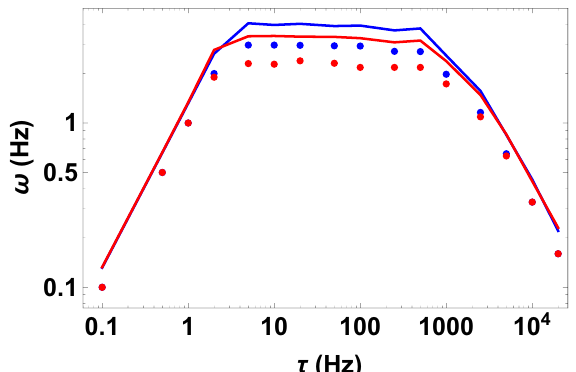
Figure 5. Angular frequency of the last circular trajectory of trapped enantiomers ( δ > 0 blue and δ < 0 red) versus τ (the continuous line shows the predicted results from Equation